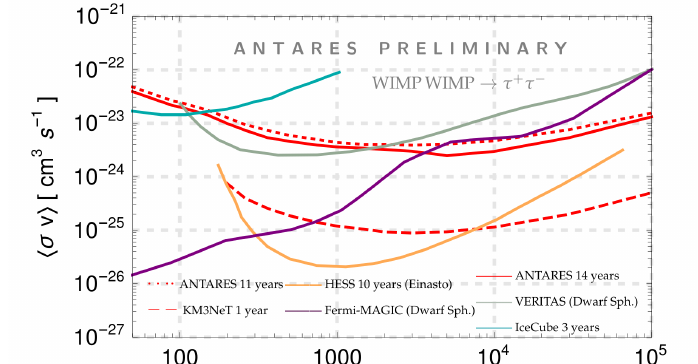
Figure 5. Upper limits at 90% CL on the thermally averaged cross section for WIMP pair anni- hilation as a function of the WIMP candidate mass set with 14 years of ANTARES data [52], in comparison with the measurement from IceCube [98], H.E.S.S. [99], VERITAS [100] and Fermi- LAT+MAGIC [101], for the τ + τ − channel and NFW dark matter halo [102], unless specified. The sensitivity that could be reached with KM3NeT in one year is shown in dashed red. Credit: ANTARES and KM3NeT